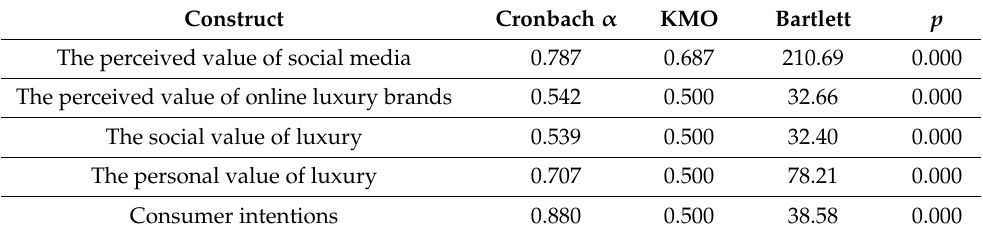
Table 1. The analysis of the psychometric properties of the scales